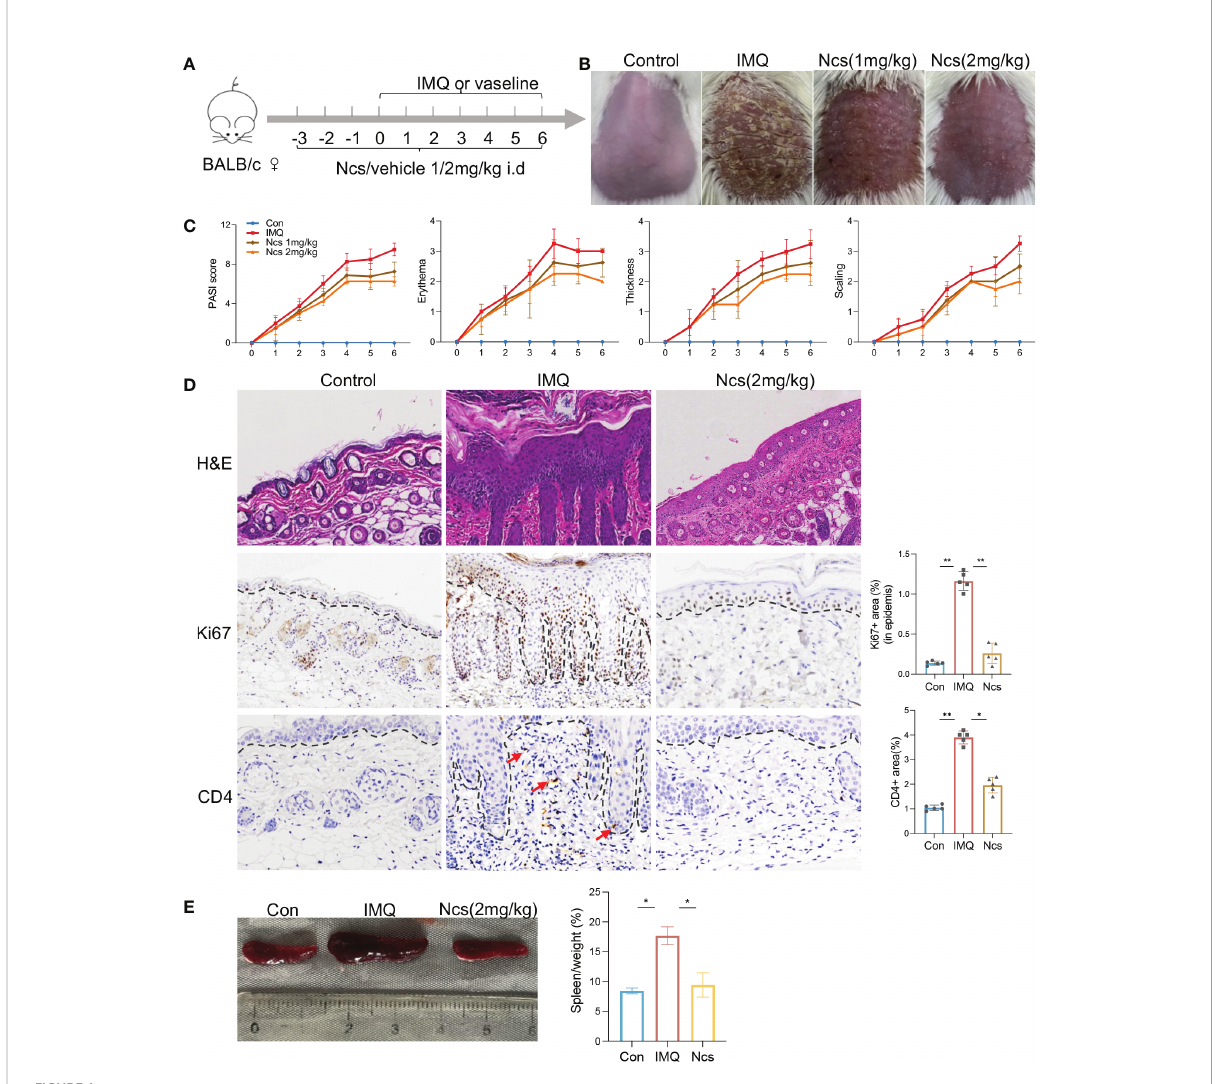
FIGURE 1 Ncs alleviated IMQ-induced psoriatic skin in fl ammation in mice. (A) Mice were pretreated with Ncs or vehicle for 3 days by intradermal injection. Imiquimod or vaseline cream was introduced in day 0 and mice were sacri fi ced in day 6. (B) Phenotypic presentation of lesional skin in day 6 (one representative mouse given, n=5). (C) Clinical scores for erythema, scaling, and thickness of the dorsal skin were counted daily, and the PASI score was calculated by summing the scores from the three independent criteria. (D) H&E staining and immunohistochemical determination of Ki67+ and CD4+ cell in fi ltration in skin tissue of each group. Magni fi cation, 200X. For counting Ki67+ (in epidermis) and CD4+ area, fi ve fi elds in each section of each sample were calculated. (E) Representative pictures of the spleen from the indicated group and spleen index (spleen weight as a percentage of body weight) was calculated on day 6. Data are representative of three independent experiments with 5 samples per group in each. Data are presented as the mean ± SEM. P-values were determined using t test by Prism 8; * p <0.05; ** p